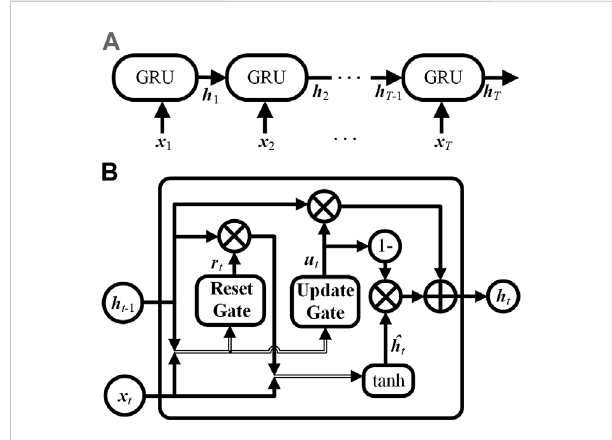
FIGURE 1 Structure of GRU network, (A) is GRU network overall structure, (B) is GRU internal